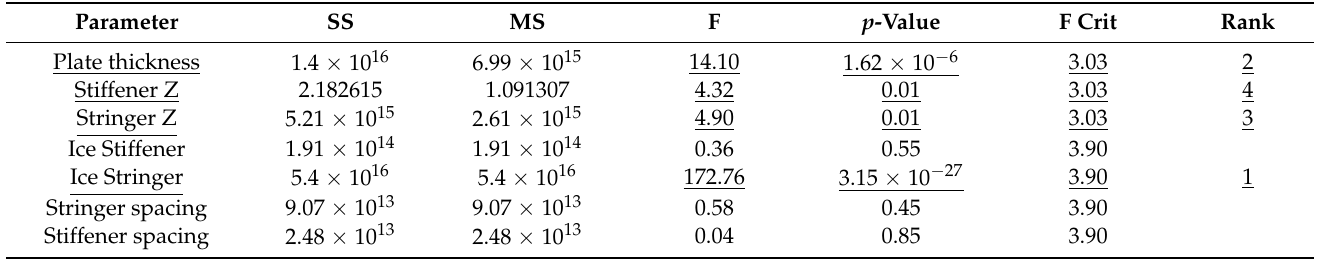
Table A2. Aluminum alloy grillage SSF: Statistically significant parameters are